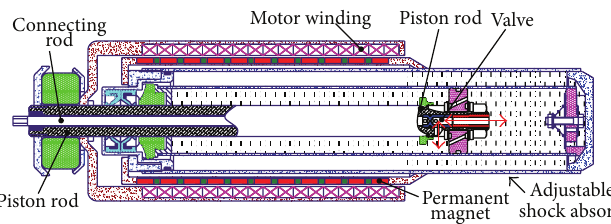
Figure 1: Schematic view of the proposed actuator in HASAS.